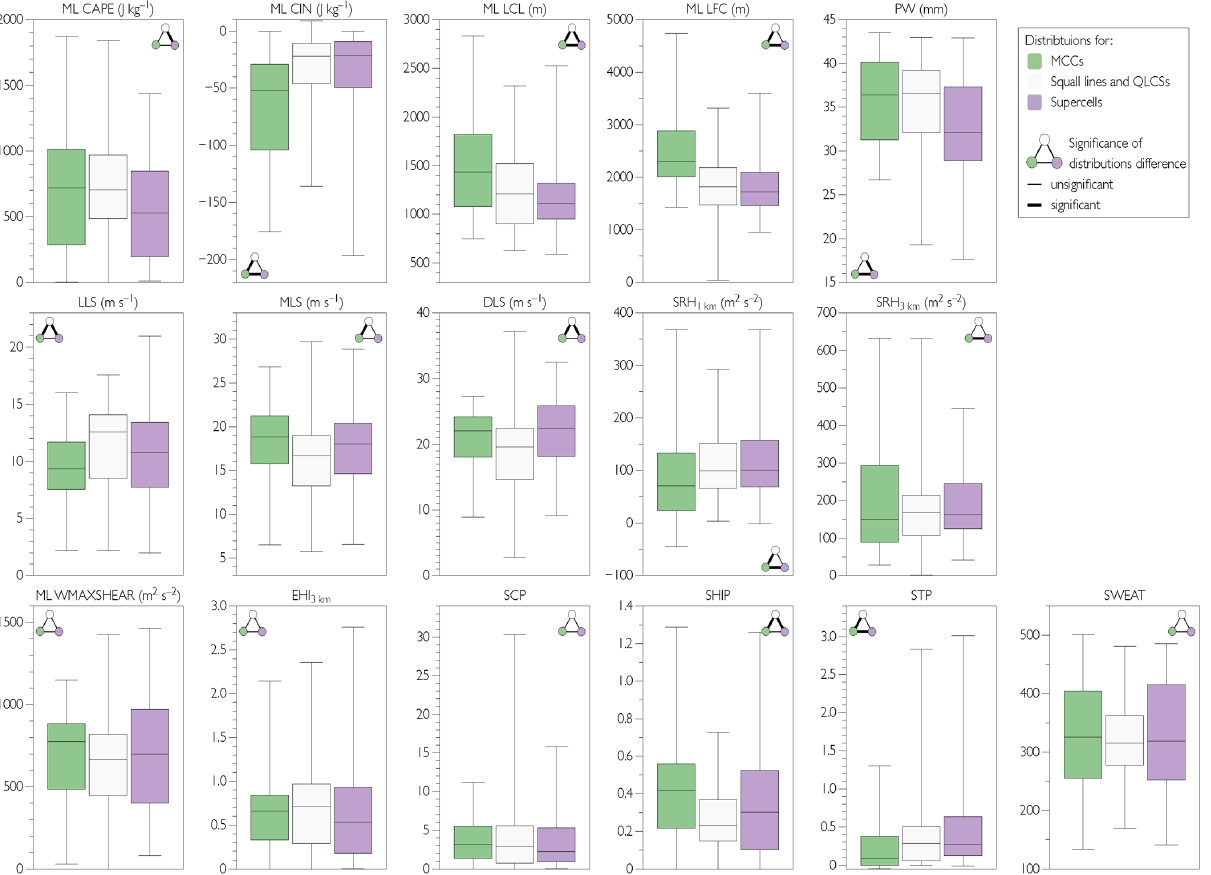
Figure 8. Distribution of various environmental variables separately for supercells (132 events), quasilinear convective storms (105 events), and mesoscale convective complexes (44 events). The statistically significant difference is highlighted.